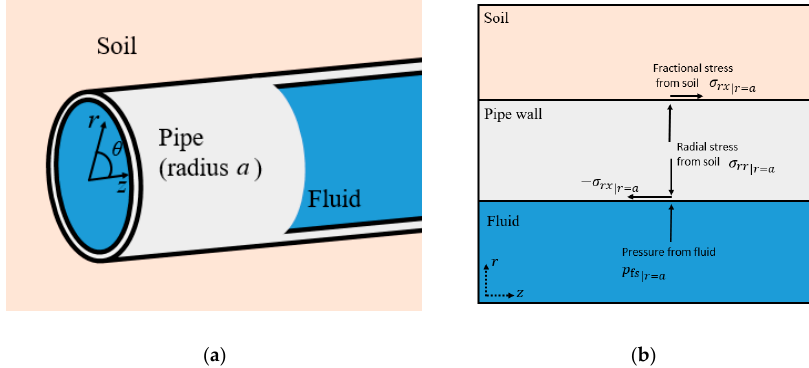
Figure 2. An analytical model of a buried pipe: ( a ) the co-ordinate system; ( b ) stresses acting at the pipe–soil interface, modified from [58], Copyright Elsevier,